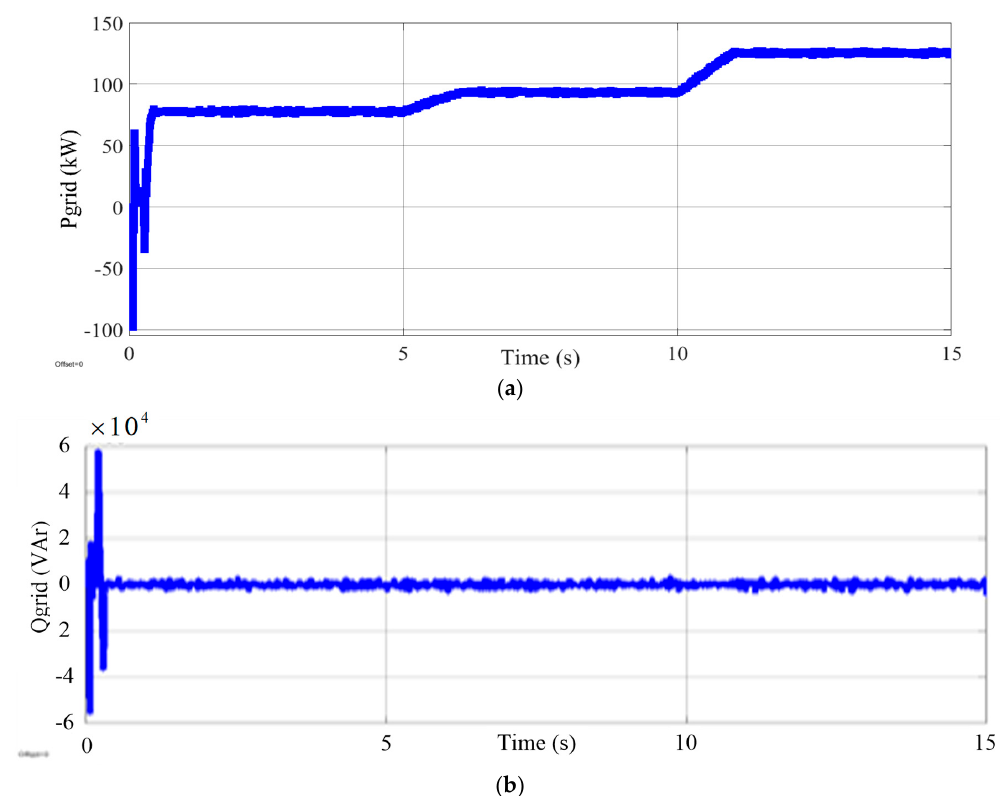
Figure 13. The active and reactive power of the utility grid: ( a ) Active power (kW); ( b ) Reactive power (VAr).